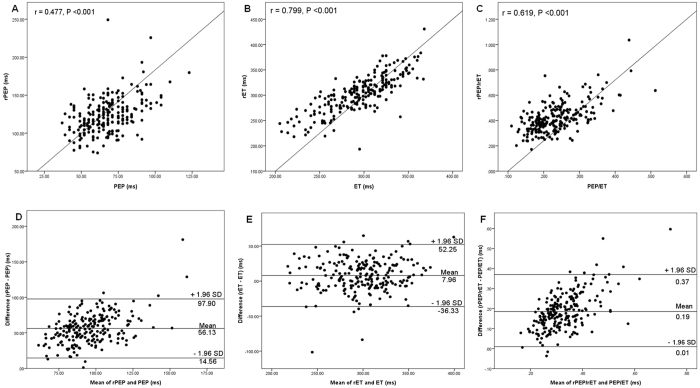
The scatter plots between pre-ejection period (PEP) and renal PEP (rPEP) (A), ejection time (ET) and renal ET (rET) (B), and PEP/ET and rPEP/rET (C) and Bland-Altman plots of PEP and rPEP (D), ET and rET (E), and PEP/ET and rPEP/rET (F) in all subjects.